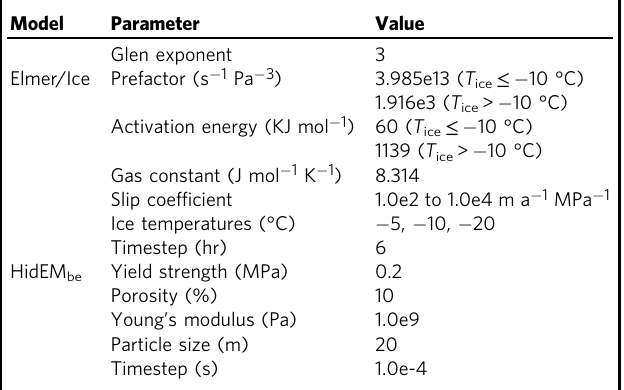
Table 2 Key parameters in Elmer/Ice – HiDEM be of fl ine model coupling work fl ow used to derive the ice-cliff retreat rate